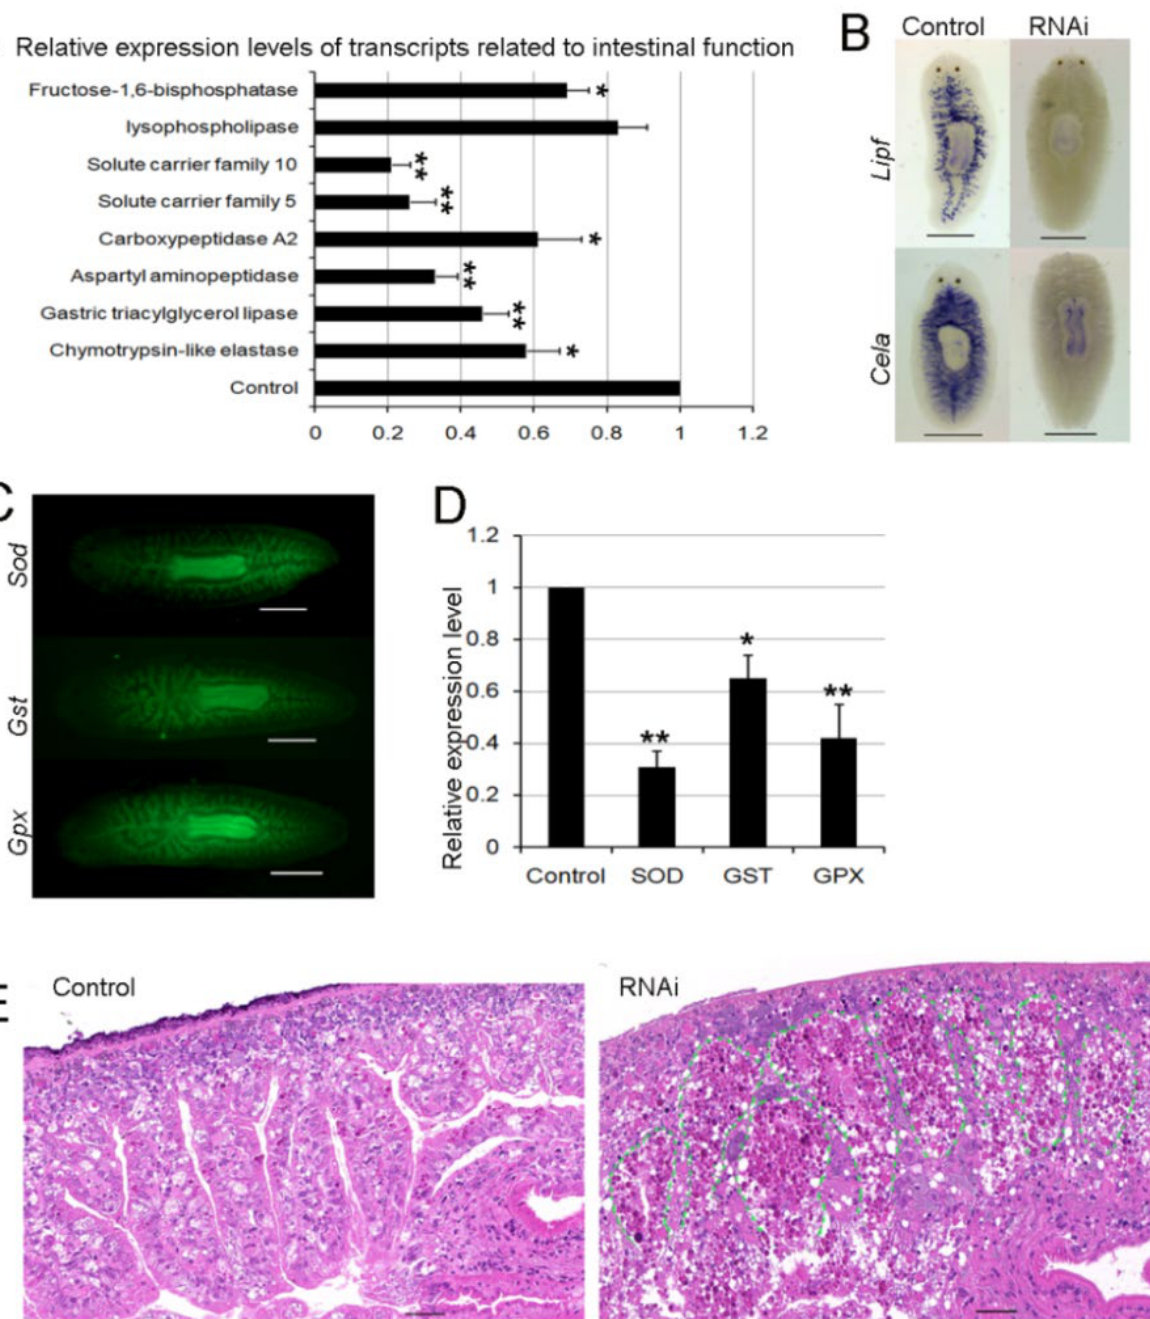
Figure 9. Effects of RNAi- Djhsp60 on the structure and function of intestinal tissues. ( A ) Relative expression levels of transcripts related to intestinal function detected by qRT-PCR. Asterisks indicate statistical differences (* p < 0.05, ** p < 0.01). ( B ) Expression patterns of gastric triacylglycerol lipase ( Lipf ) and chymotrypsin-like elastase ( Cela ) after RNAi revealed by WISH. Color development for 30 min. Scale bar: 0.5 mm. ( C ) Expression patterns of antioxidant enzymes in normal animals revealed by FISH. Scale bar: 0.5 mm. ( D ) Relative expression levels of antioxidant enzymes after RNAi detected by qRT-PCR. Asterisks indicate statistical differences (* p < 0.05, ** p < 0.01). ( E ) Morphological changes of intestinal tissues after RNAi revealed by HE staining. The green dashed line indicates the border between parenchymal tissues and intestinal tissues. Scale bar: 50 μm.